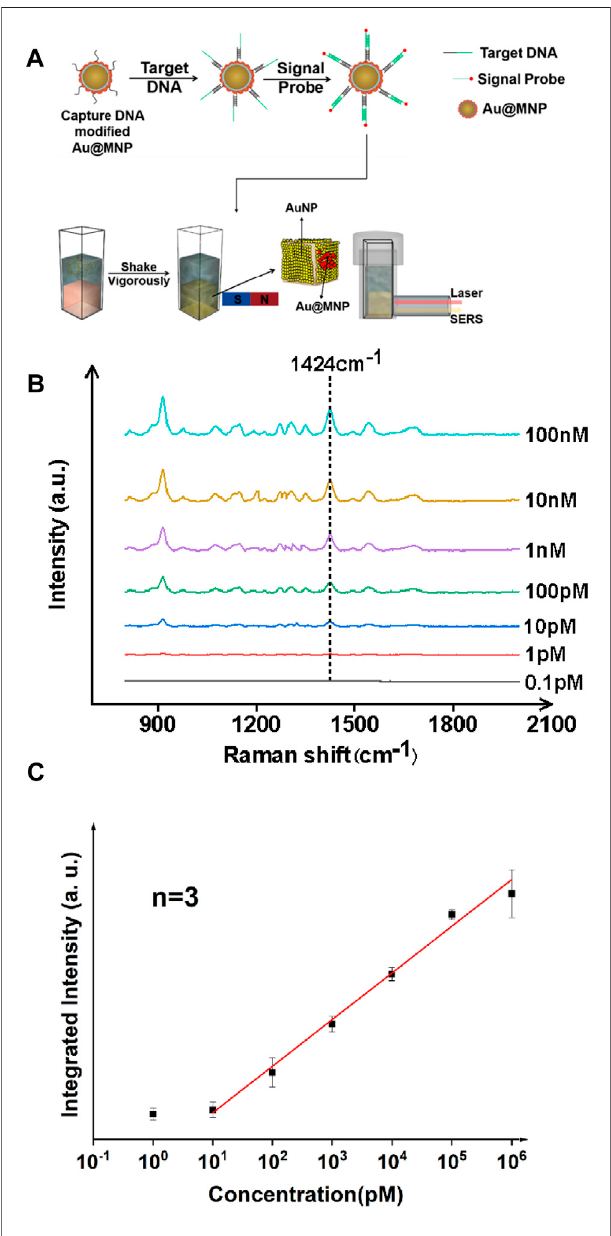
FIGURE 1 | Ultrasensitive detection of nucleic acid fragments of S. aureus with the liquid-state SERS platform. (A) Sample preparation and analysis fl owchart. (B) SERS spectra of nucleic acid samples with different concentrations. (C) Concentration vs. integrated intensity curve using a signature peak at 1,424 cm − 1 , showing linearity of the SERS signal from ∼ 10 pM to 10 6 pM. The error bar was obtained by fi nding mean to six measurements on the same sample, and averaged out of three samples. The signal probe used in this case was Cy3, a standard Raman dye for DNA